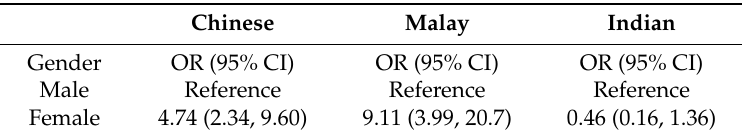
Table 3. Multivariable adjusted * associations of gender with suboptimal 25(OH)D concentration stratified by ethnicity.